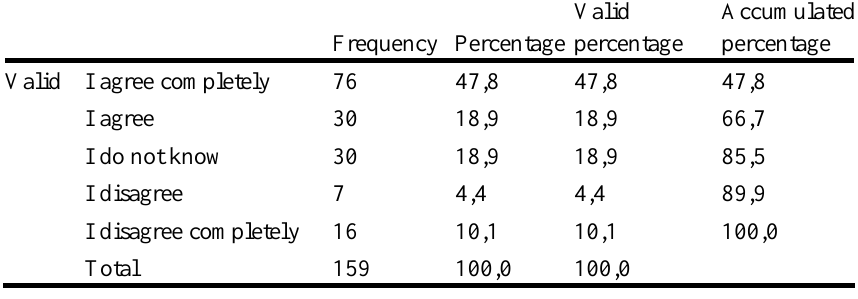
Valid percentage questionnaires´ results, question 11 “Students wait enthusiastically for bilingual lessons”